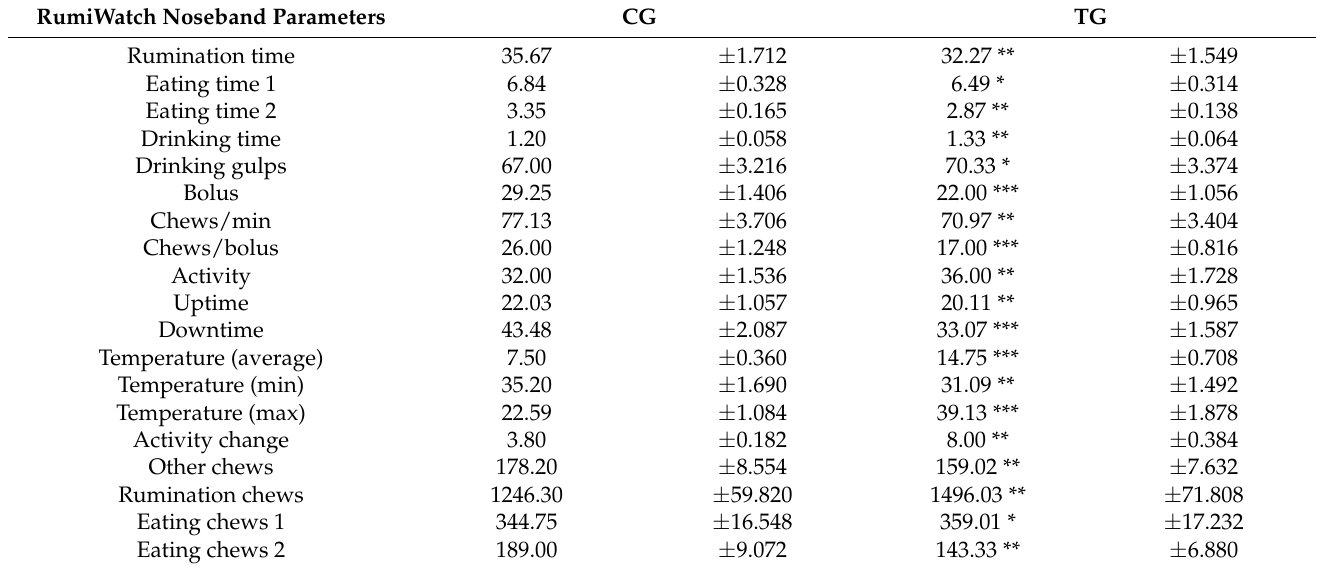
Table 4. RumiWatch noseband (RWS) parameters on the calving